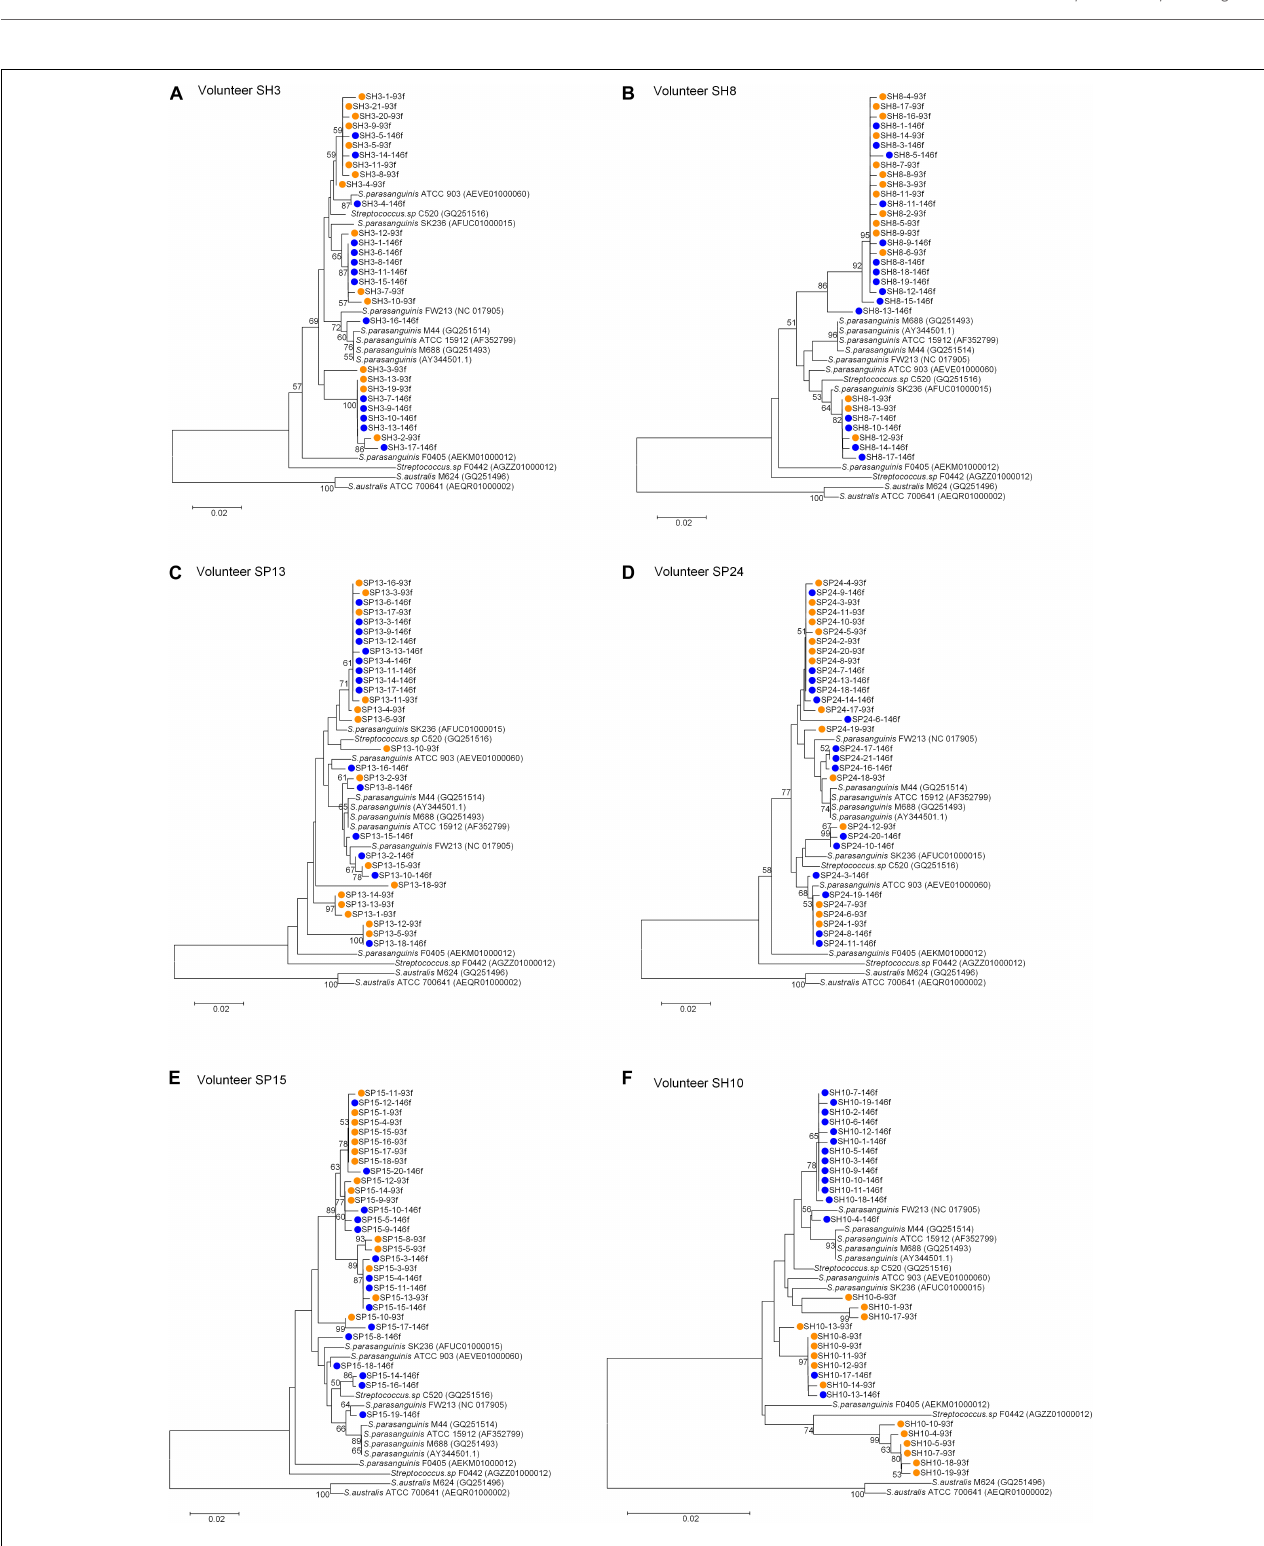
FIGURE 3 | Phylogenetic trees of the groEL gene fragments cloned by the primer pair Spa146f-Spa525r and Spa93f-Spa525r from the saliva of individual human subjects and those of known Streptococcus species. The sequences cloned with Spa146f-Spa525r are labeled with blue dots, and those cloned with Spa93f-Spa525r are labeled with orange dots. Bootstrap values greater than 50% are indicated at the nodes. (A) The tree of sequences cloned from the saliva of human subject SH3; (B) The tree of sequences cloned from the saliva of human subject SH8; (C) The tree of sequences cloned from the saliva of human subject SP13; (D) The tree of sequences cloned from the saliva of human subject SP24; (E) The tree of sequences cloned from the saliva of human subject SP15; (F) The tree of sequences cloned from the saliva of human subject SH10.